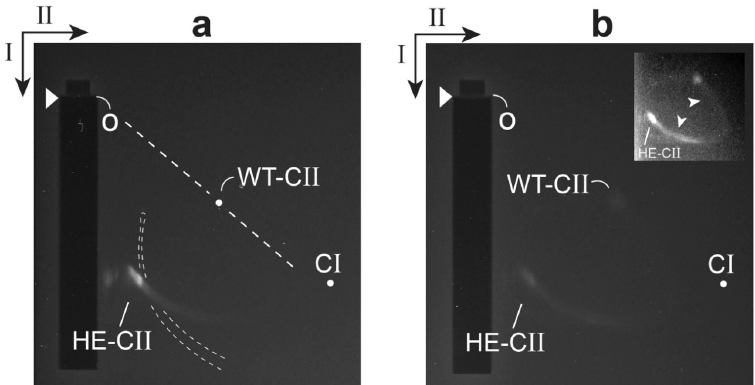
Figure 3. Analysis by 2d-AGE of hyper-expanded T3 ipDNA-capsid II. The ipDNA-capsid II is from the Nycodenz gradient-isolation in Figure 4b of reference [35]. Two fractions of the Nycodenz density gradient were analyzed by 2d-AGE, the ( a ) 1.073 g/mL and ( b ) 1.099 g/mL fractions. The procedure of 2d-AGE is described in reference [26]. The first dimension was run in a 0.30% agarose gel at 2.0 V/cm for 5.0 h. The second dimension was run in a surrounding 2.0% agarose gel at 1.8 V/cm for 16.0 h. The electrophoresis buffer was 0.09 M Tris-acetate, pH 8.3, 0.001 M MgCl 2 . The temperature was 25 ± 0.3 °C. Seakem LE agarose was used (Lonza, Basel, Switzerland). The arrowheads indicate the leading edges of sample wells. The arrows indicate the directions of the first (I) and second (II) dimension electrophoresis. The curved dashed lines indicate the profile of variable length DNAs (no protein attached) from the DNA fraction of the same Nycodenz gradient. The DNA profile was obtained in a separate quadrant embedded in the same agarose frame as the gels of ( a , b ).